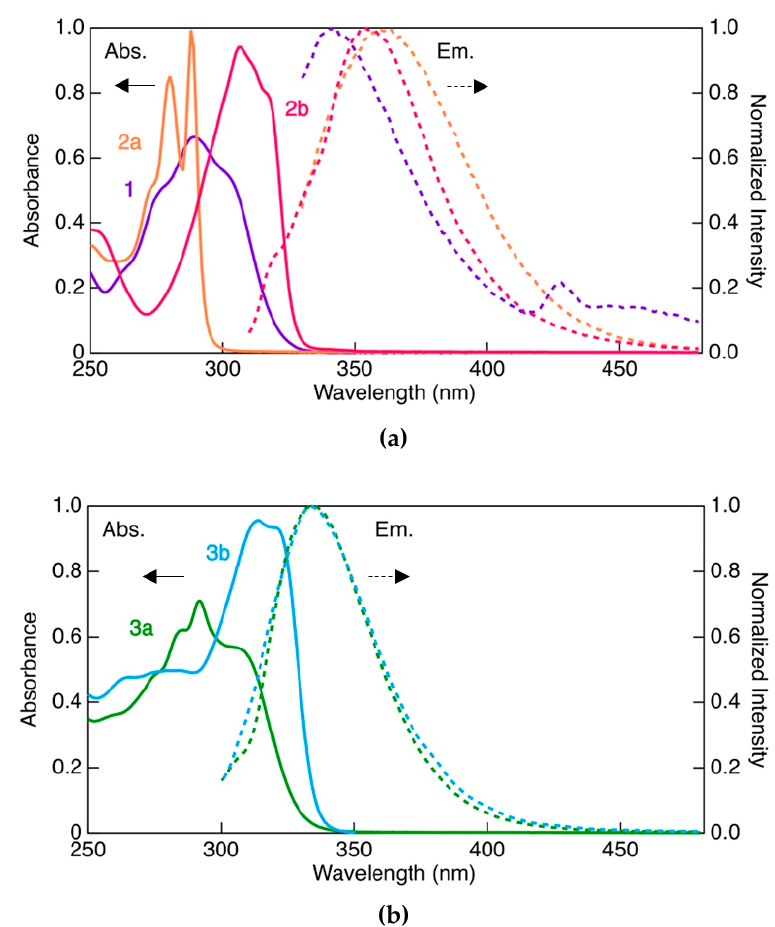
Figure 5. Photophysical properties of Au complexes in dilute CH 2 Cl 2 solutions: solid line, absorption spectra; dashed line, photoluminescence spectra. ( a ) Complexes 1 and 2 and ( b ) complexes 3 . UV-vis absorption concentrations: [ 1 ] = 2.7 × 10 − 5 mol L − 1 , [ 2a ] = 4.5 × 10 − 5 mol L − 1 , [ 2b ] = 4.0 × 10 − 5 mol L − 1 , [ 3a ] = 2.0 × 10 − 5 mol L − 1 , [ 3b ] = 2.0 × 10 − 5 mol L − 1 . Luminescence concentrations: [ 1 ] = 2.7 × 10 − 6 mol L − 1 , [ 2a ] = 4.5 × 10 − 6 mol L − 1 , [ 2b ] = 4.0 × 10 − 6 mol L − 1